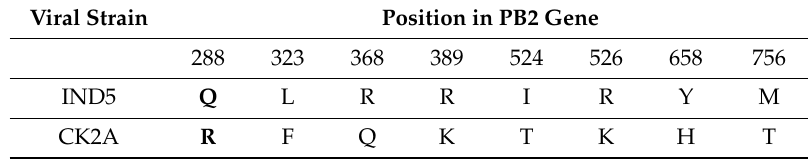
Table 3. Comparison of amino acid variations in the PB2 segments of the IND5 and CK2A strains. Viral